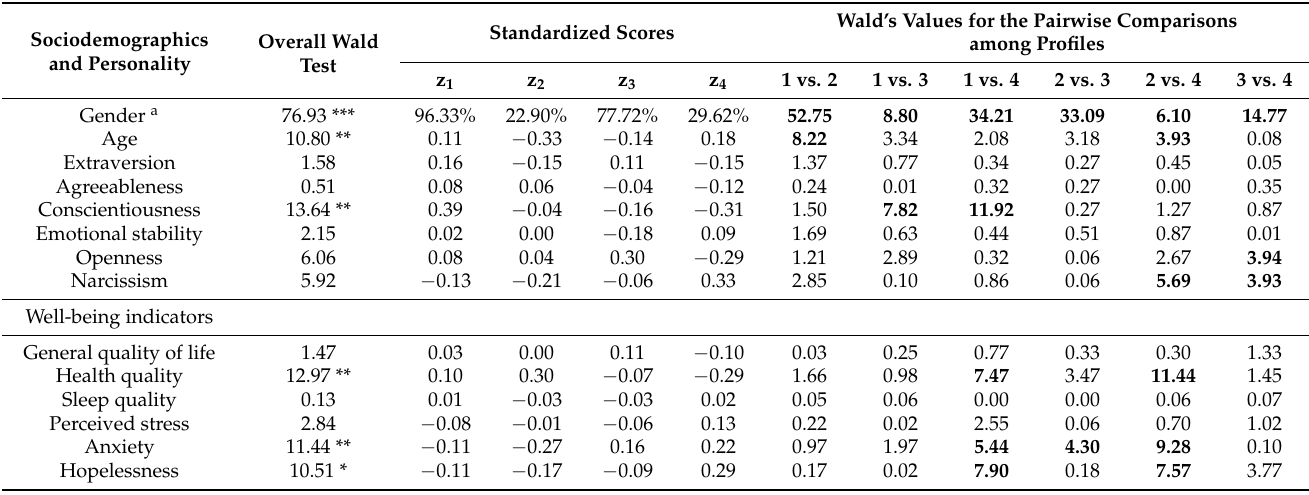
Table 6. Potential Predictors and Outcomes of LPA Membership: Comparison of